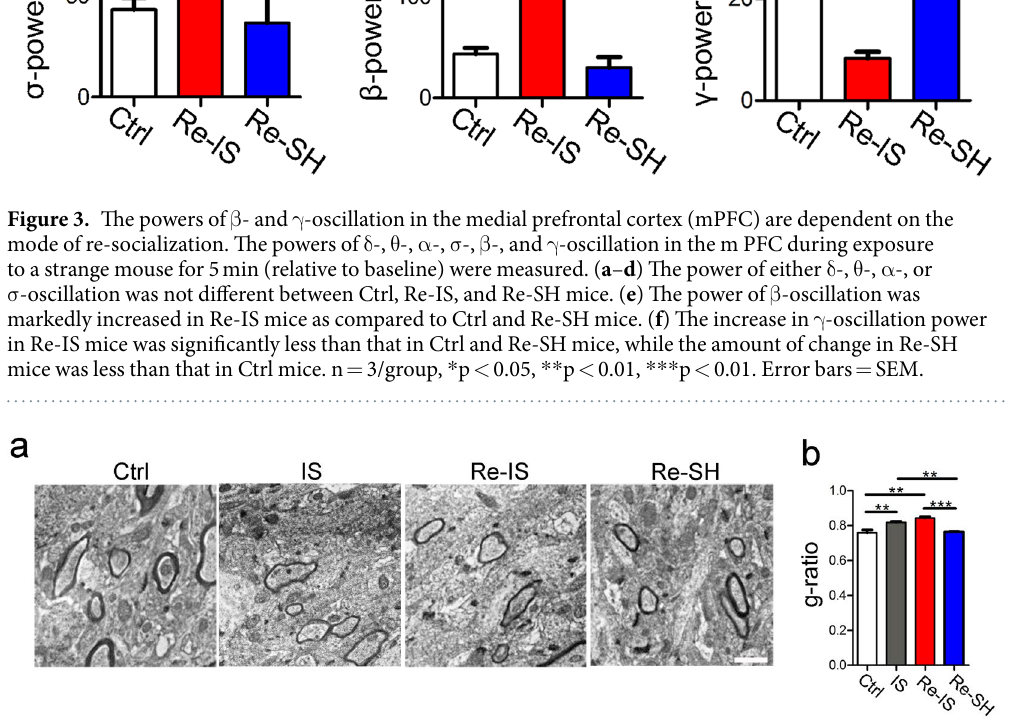
Figure 4. Myelin thickness in the medial prefrontal cortex (mPFC) depends on the mode of re-socialization. ( a ) Images of myelinated axons in layer V of the mPFC. ( b ) The average g-ratio of axons from each mouse (n = 3) was used as a statistical value. The statistical comparison of Ctrl, IS, Re-IS, and Re-SH mice showed that the myelin of IS and Re-IS mice was thinner than that of Ctrl and Re-SH mice, while Ctrl and Re-SH mice showed comparable myelin thickness (more than 50 axons/each mouse, n = 3/group), ** p < 0.01, *** p < 0.001, scale bar = 0.5 μ m. Error bars =